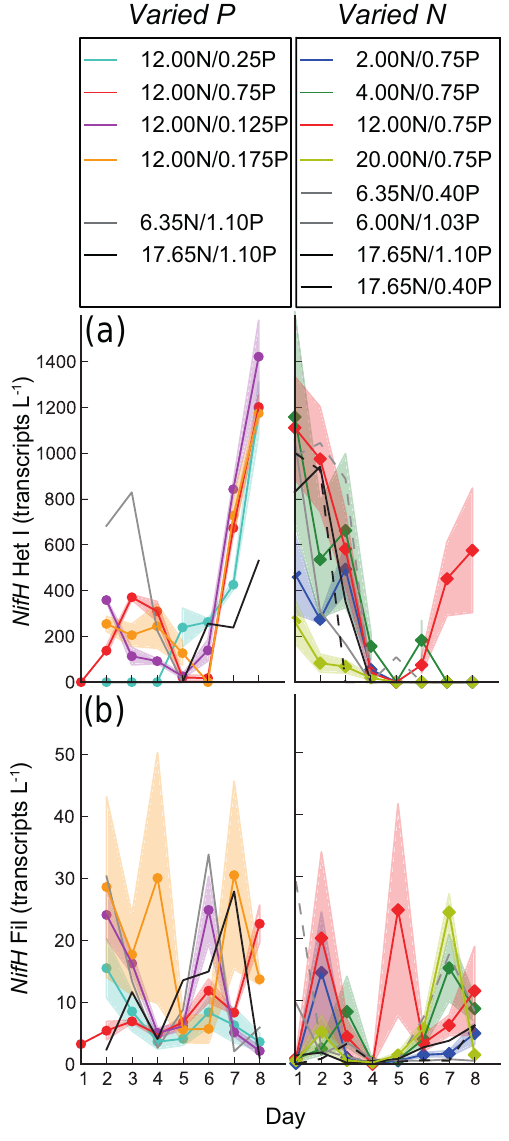
Figure 8. Temporal development of transcript abundances for (a) Richelia - Rhizosolenia (Het I) and filamentous cyanobacteria re- lated to Trichodesmium (Fil). Standard deviations are depicted as shaded error